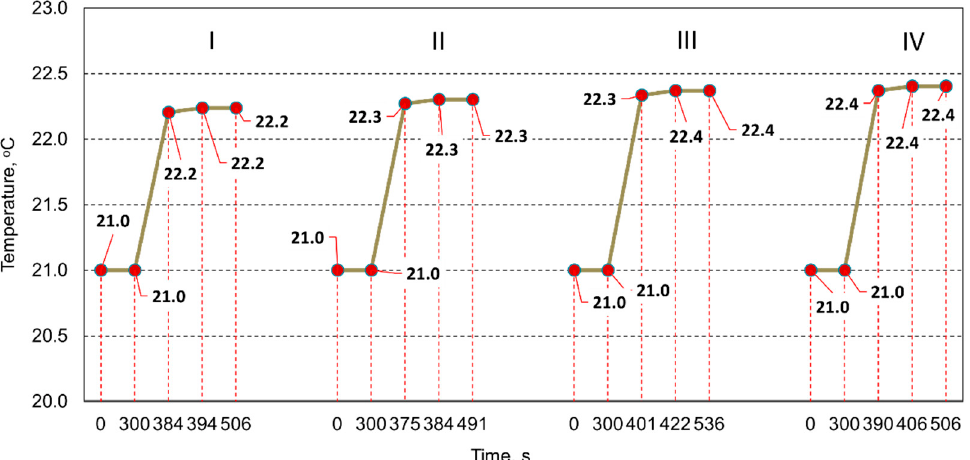
Figure 12. Characteristics of combustion temperature of a fir tree sample conditioned with a pulsed electric field: I (electric field intensity 25 kV · cm − 1 and number of pulses 150); II (electric field intensity 25 kV · cm − 1 and number of pulses 300); III (electric field intensity 30 kV · cm − 1 and number of pulses 150); IV (electric field intensity 30 kV · cm − 1 and number of pulses 300).